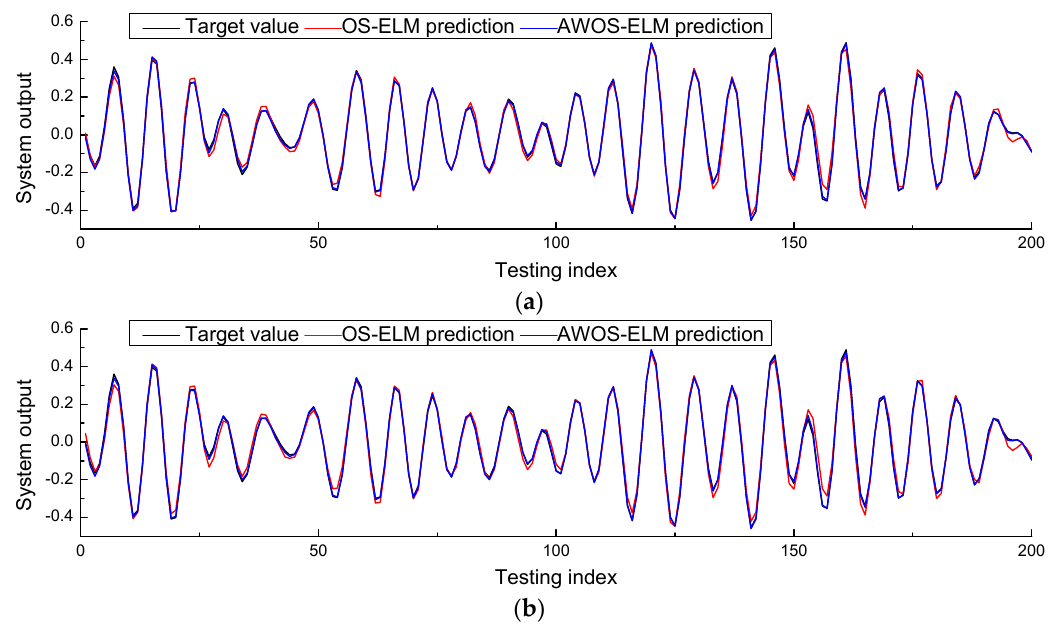
Figure 4. Comparison of the prediction ability of the OS-ELM algorithm and the AWOS-ELM algorithm. ( a ) Sigmoid function; ( b ) RBF function. Table 3. Performance comparison between AWOS-ELM and OS-ELM on the robot arm example.